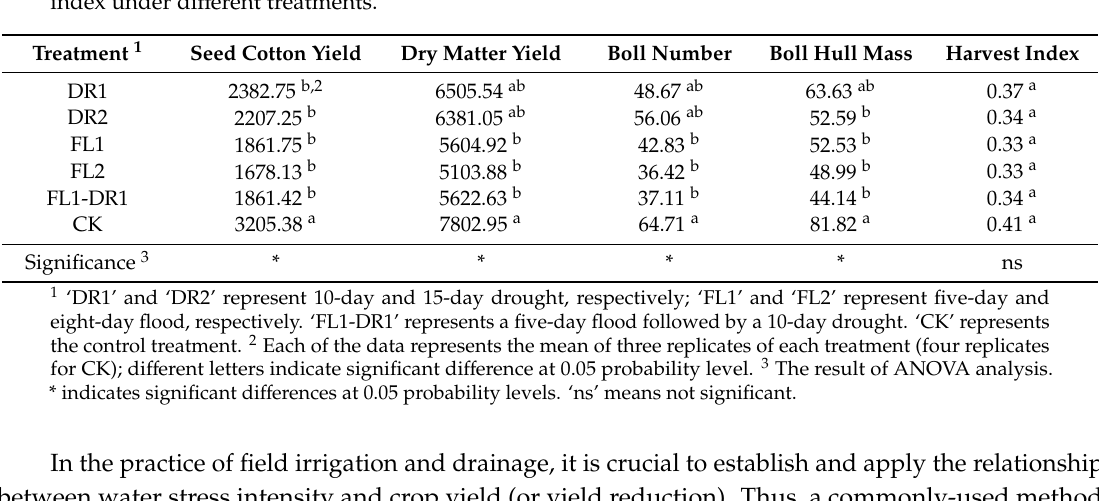
Table 3. The responses of seed cotton yield, dry matter yield, boll number, boll hull mass, and harvest index under di ff erent